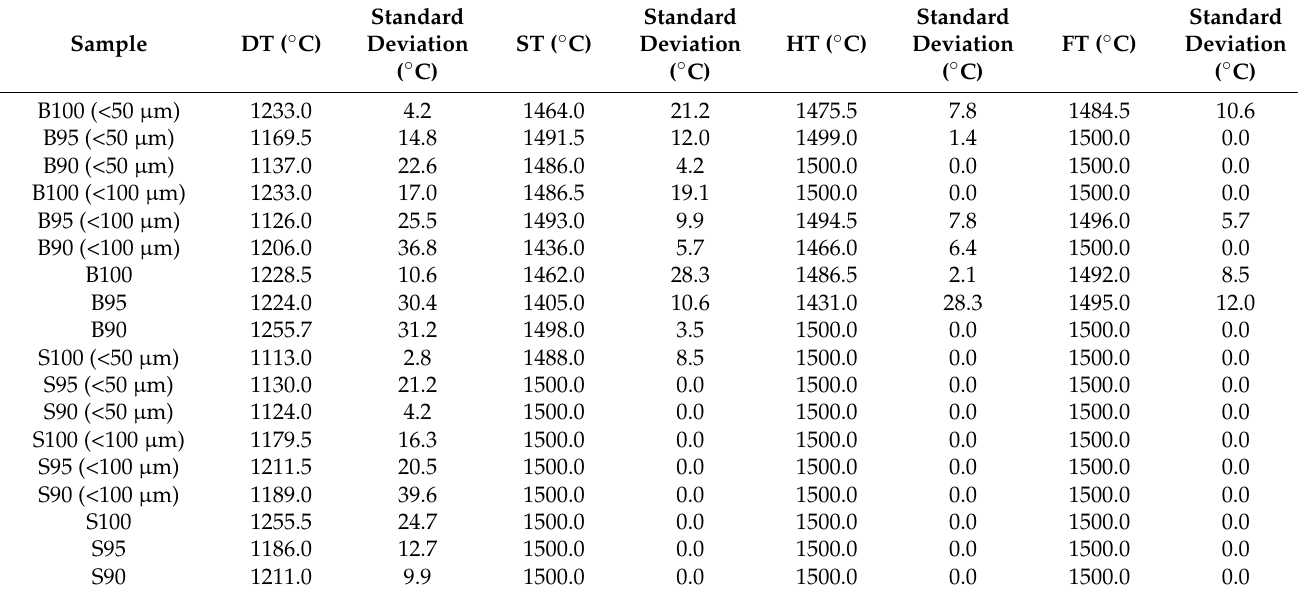
Table 2. Resulting values of ash melting temperatures prepared at 550 ◦ C with their standard